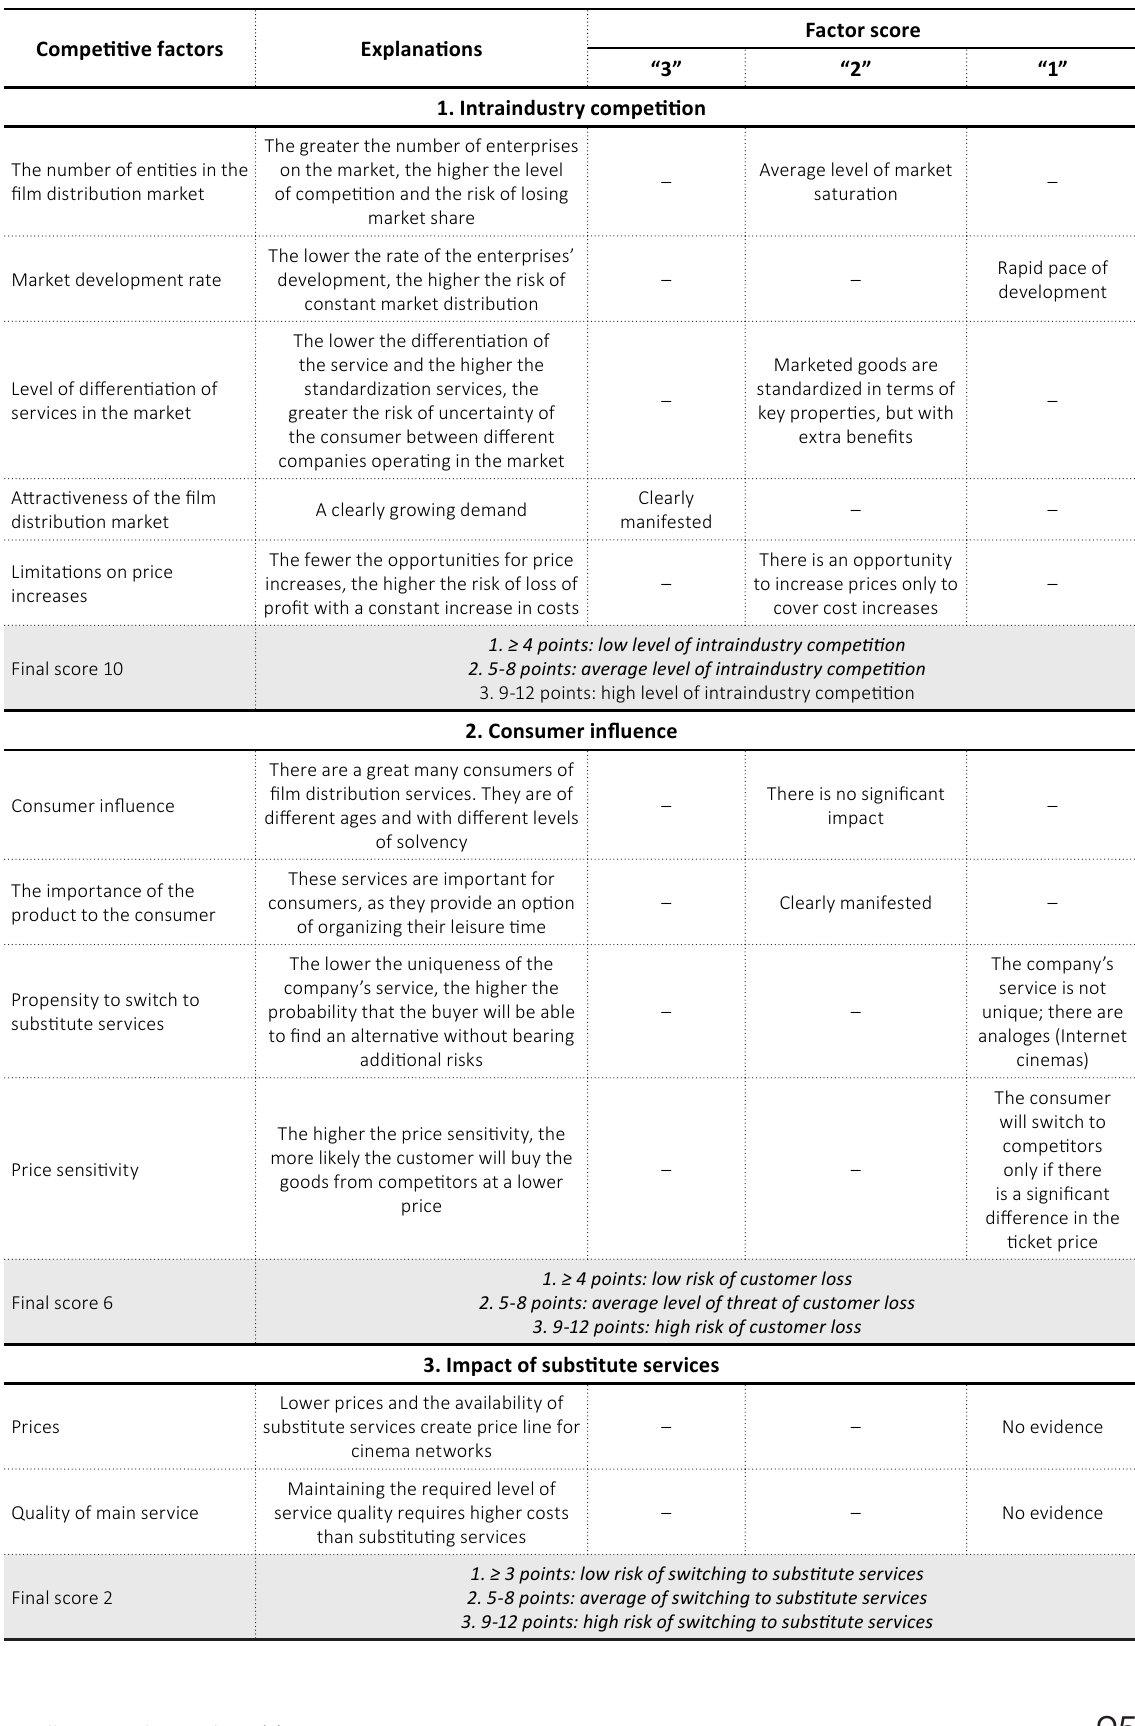
Table 1. Competitive analysis of cinema chains by Porter’s Five Forces Framework method Competitive